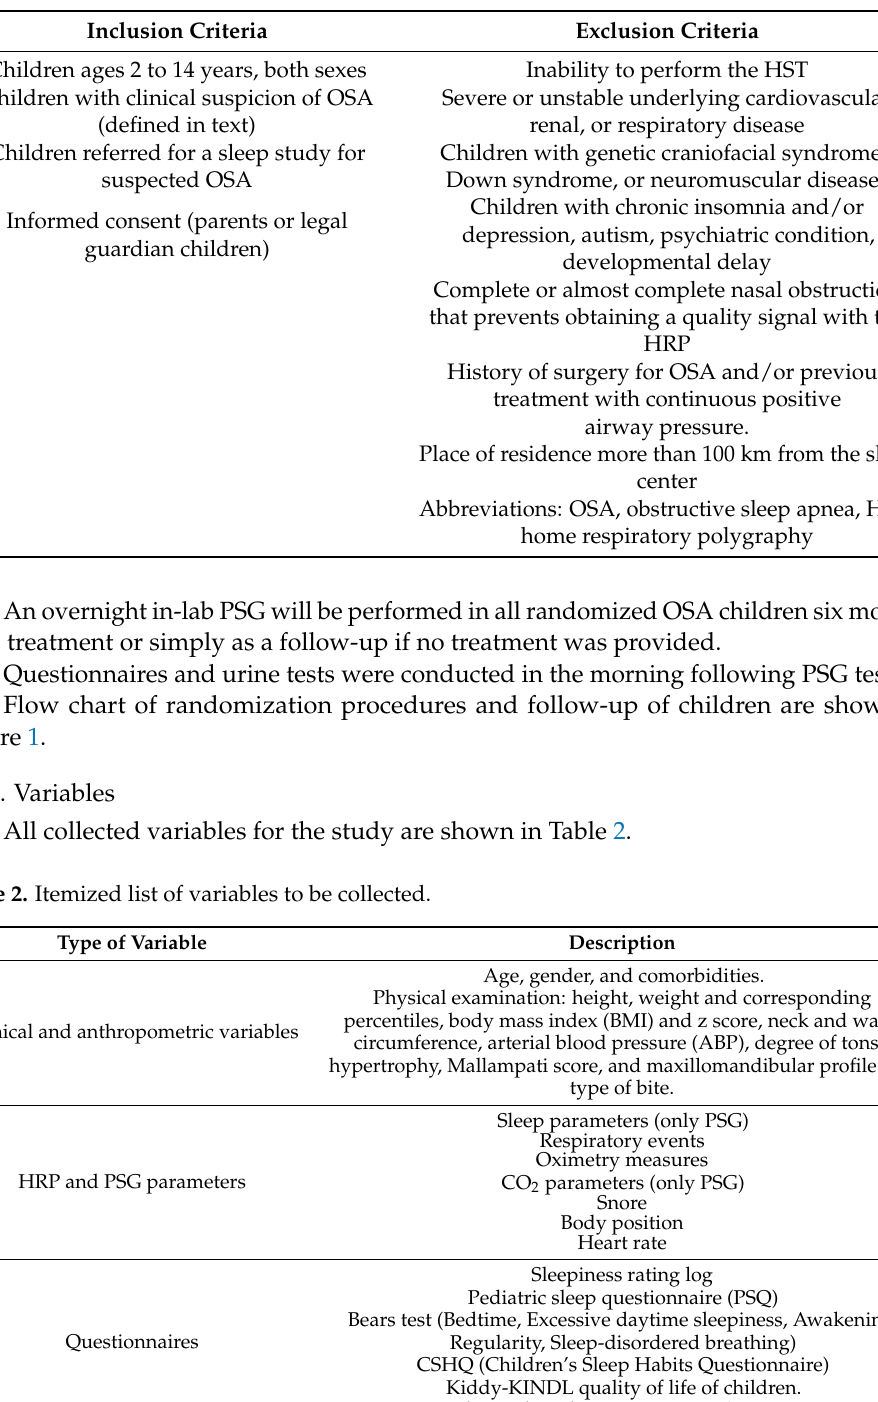
Pictorial-Based Declarative Memory